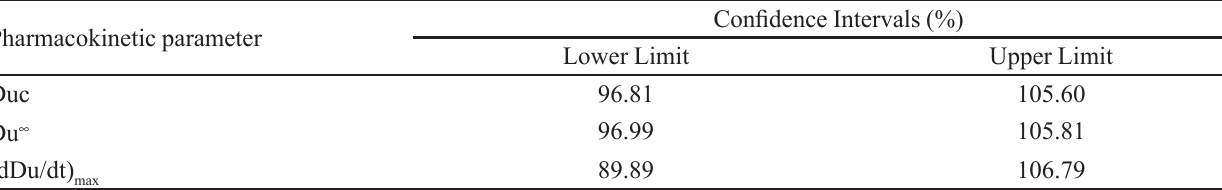
TABLE V - Confidence intervals (90%) for the ratio of ln -transformed data of Duc , Du ∞ and ( dDu/dt ) of cephalexin immediate-release tablets (A and B products,